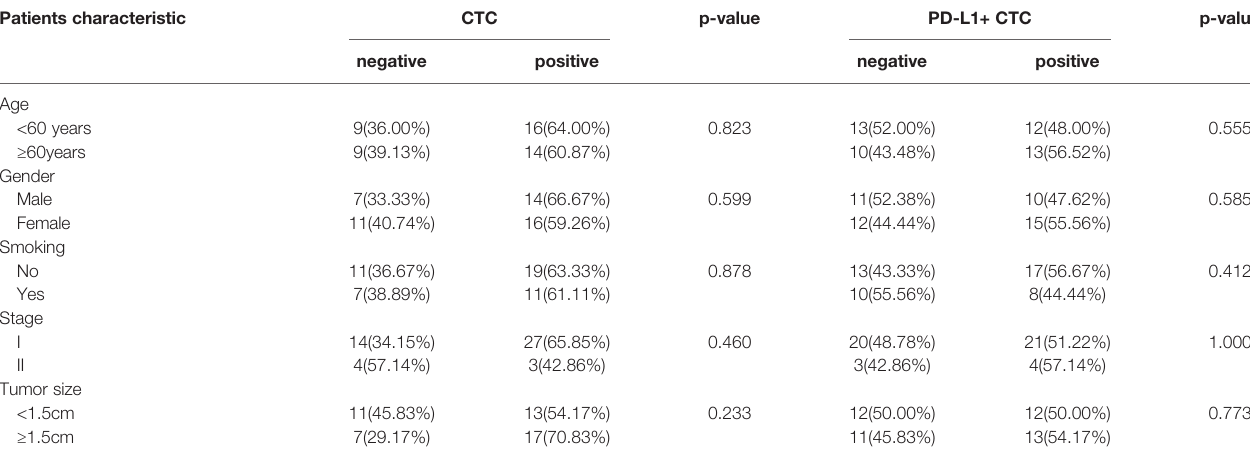
TABLE 1 | Clinical characteristics of patients. Patients